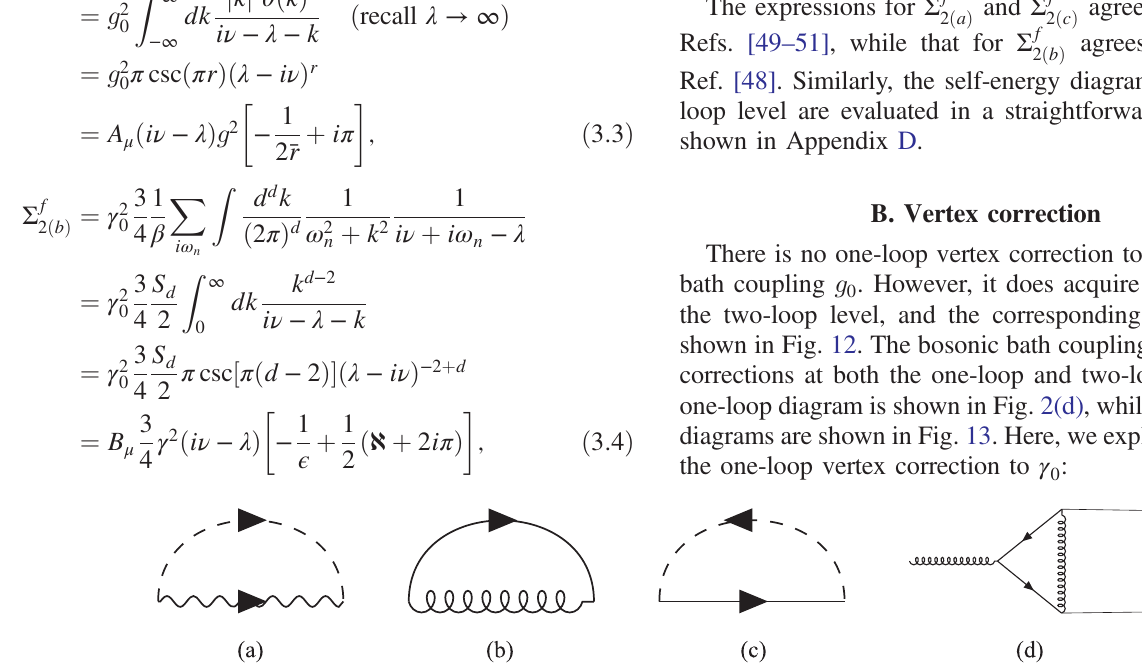
FIG. 2. One-loop diagrams for self-energy and vertex corrections. Fermion self-energy diagrams are shown in (a) and (b), boson self- energy is shown in (c), and the γ 0 vertex correction is shown in (d). In these diagrams, the solid line is for the f propagator, the dashed line is for the ψ propagator, the wavy line is for the b propagator, and the spiral is for the ϕ